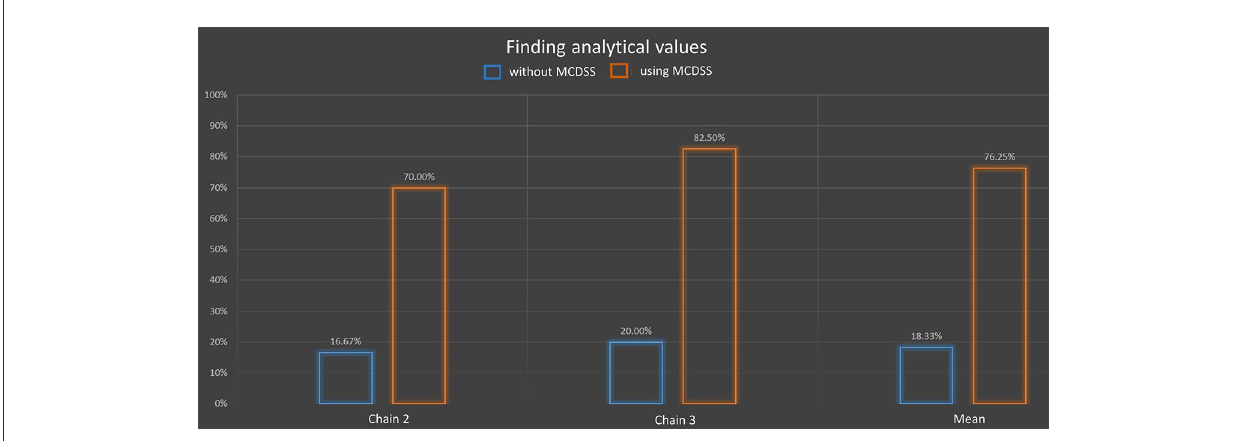
FIGURE12 Test results (blue without MCDSS, brown with MCDSS) for analytical value findings: the y-axis represents the percentage of correct answers (mean value) in two chains and on average.